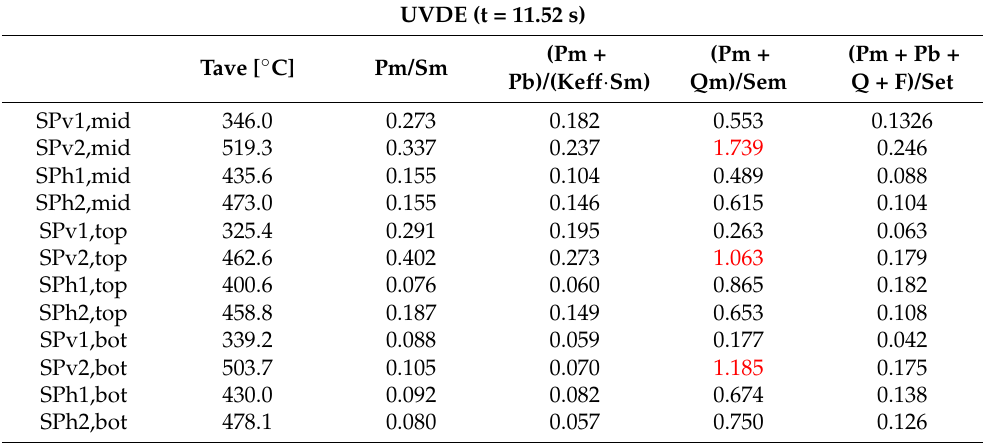
Table 8. Verification of RCC-MRx criteria under UVDE (t = 11.52 s) loading scenario.